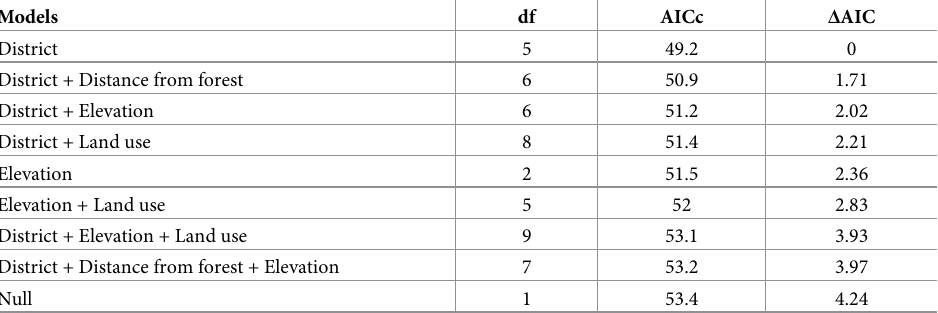
Table 2. Akaike Information Criterion (AIC) scores of generalized linear models with binomial structure predict- ing human attacks by wildlife in Parbat, Lamjung, Syangja, Tanahun and Kaski (PLSTK) districts, Nepal.